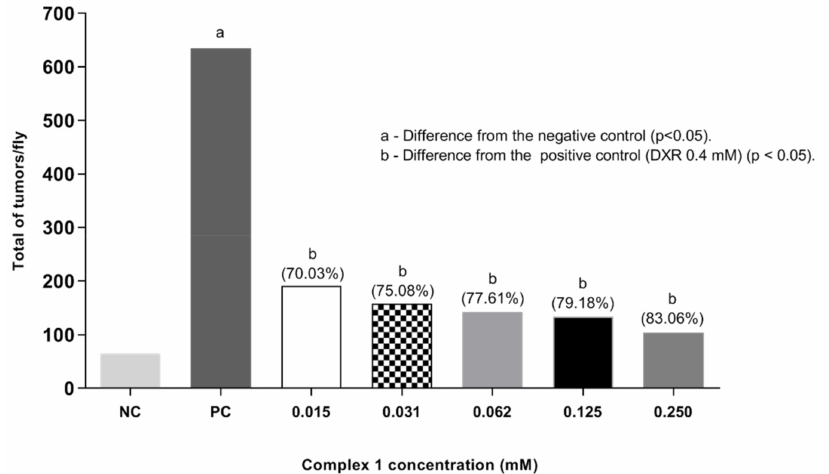
Figure 5. Tumor clones observed in the post-treatment in D. melanogaster , heterozygote for the wts tumor suppressor gene. Flies were exposed to Doxorubicin (DXR) to induce tumors and, after six hours, to different concentrations of complex 1 . Statistical diagnosis was performed according to the Mann–Whitney Test. Level of significance p < 0.05. Percentage (%) represents tumor reduction when complex 1 was associated with DXR. NC: negative control (flies treated with reverse osmosis water). PC: positive control (flies treated with 0.4 mM